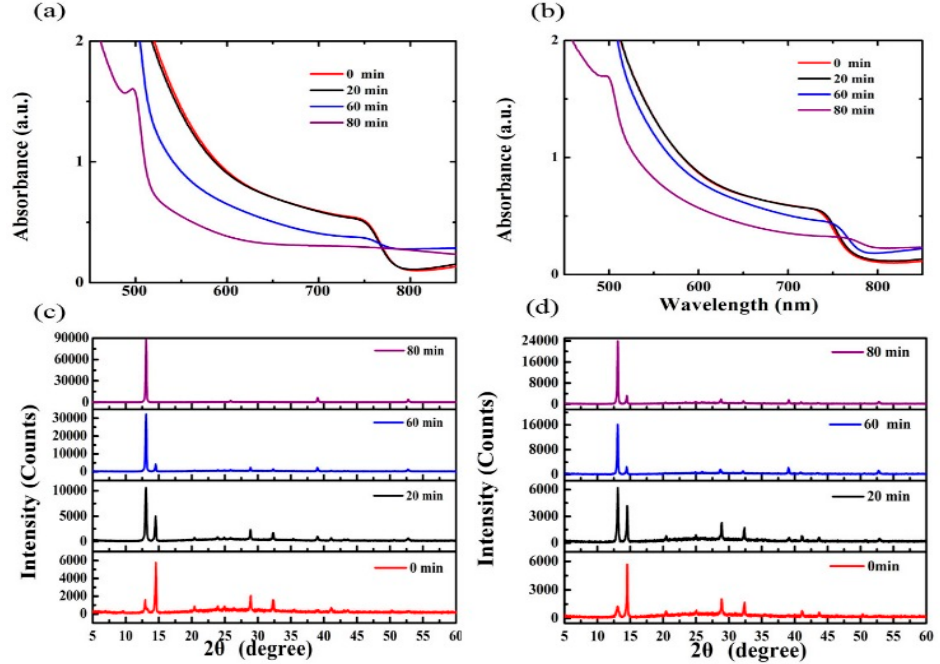
Figure 7. ( a ) The wavelength-dependent absorbance spectra of MAPbI 3 films; ( b ) MA 0.7 FA 0.3 Pb(I 0.9 Br 0.1 ) 3 films; ( c ) XRD patterns of MAPbI 3 films; and ( d ) MA 0.7 FA 0.3 Pb(I 0.9 Br 0.1 ) 3 films on glass at 150 °C for the different time scales. Table 2. Photovoltaic parameters of MAPbI 3 and MA 0.7 FA 0.3 Pb(I 0.9 Br 0.1 ) 3 PSCs before and after 24 h heated at 80 °C. a